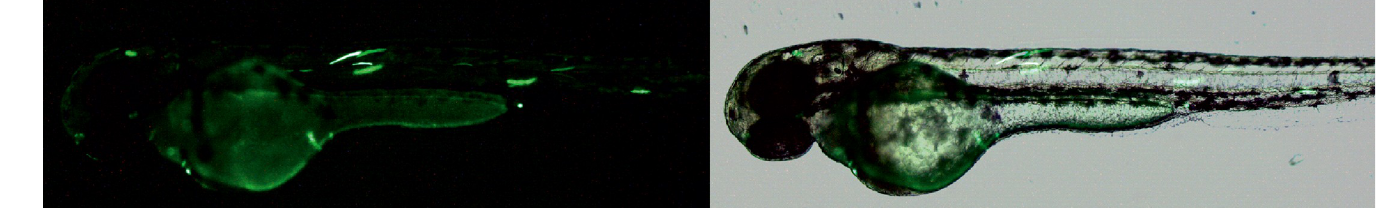
Fig 4. Detection of EGFP-positive cells in developing D . rerio embryos. Fluorescent (left) and bright/fluorescent fields (right) images are presented. 50 × magnification. The embryos at 2 days post-fertilization were injected with pCI-EGFP (0.013 fmol).